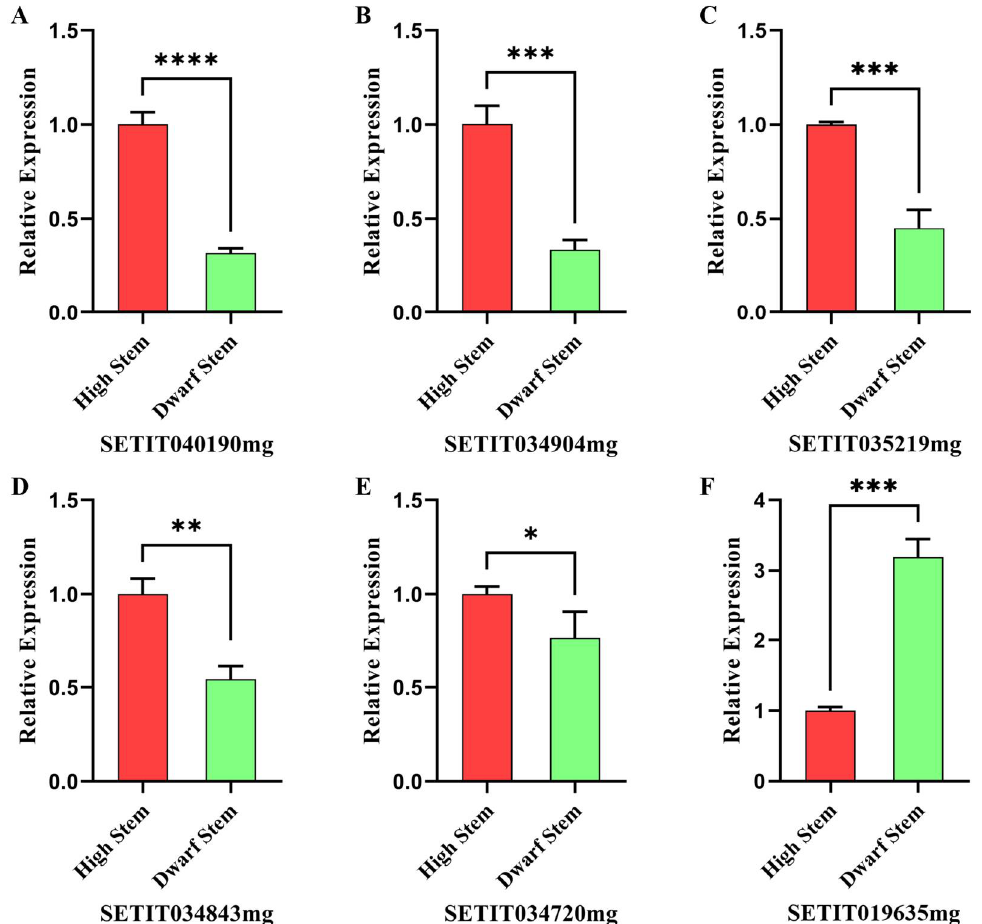
Figure 6. The results of quantitative RT-PCR (qRT-qPCR) validation. The actin gene was used as an internal control. The transcription level of the high-stem sample was set at 1.0. Asterisks indicate significant differences at various thresholds (* p < 0.05, ** p < 0.01, *** p < 0.001, **** p < 0.0001). Error bars represent the mean SE of three biological replicates. ( A – F ) Represent the relative expression of genes in different samples.